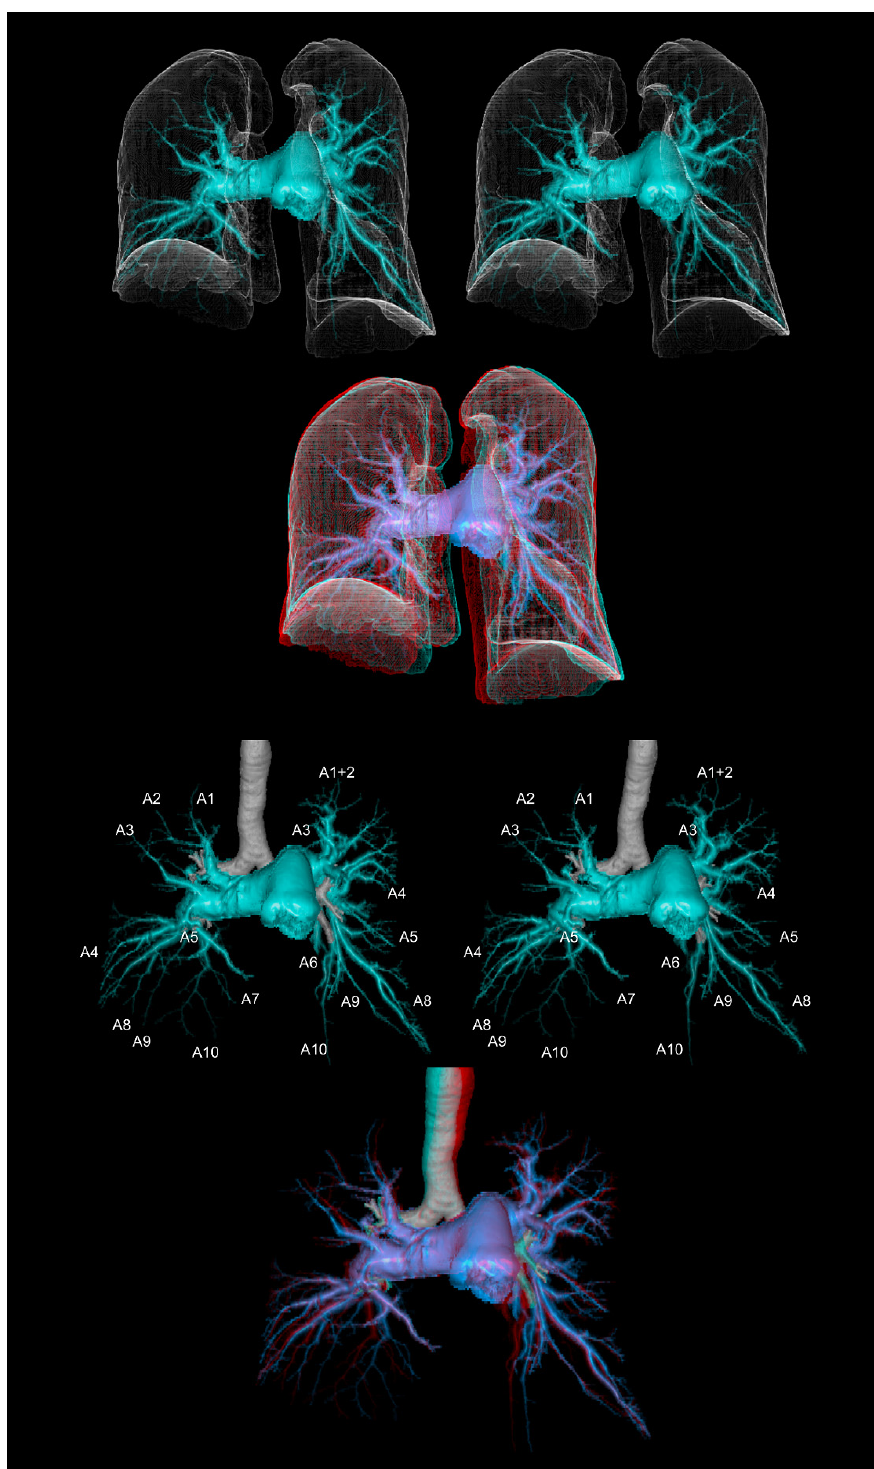
Figure 5. The computed tomographic pulmonary angiography of a patient with chronic thromboembolic pulmonary hypertension. The upper panels show the pulmonary arteries with the lung contours. The lower panels show the pulmonary arteries with the trachea and main bronchi. The first and second panels are aligned for cross ‐ eyed viewing. The third panel is the anaglyph. To see the anaglyph, anaglyphic glasses (red/cyan) are required.